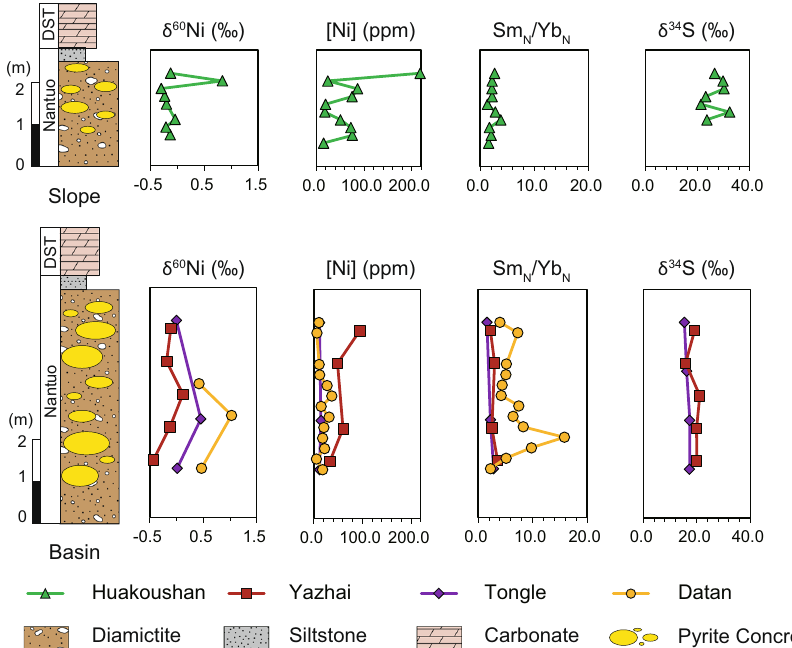
Fig. 2 The stratigraphic pro fi les of geochemical data. Stratigraphic variations of δ 60 Ni, Ni concentration, Sm/Yb (normalized by post-Archean Australian shale, PAAS), and δ 34 S of pyrite concretions in the upper Nantuo Formation. The δ 34 S values are from Lang et. al. 7 . DST here refers to Doushantuo